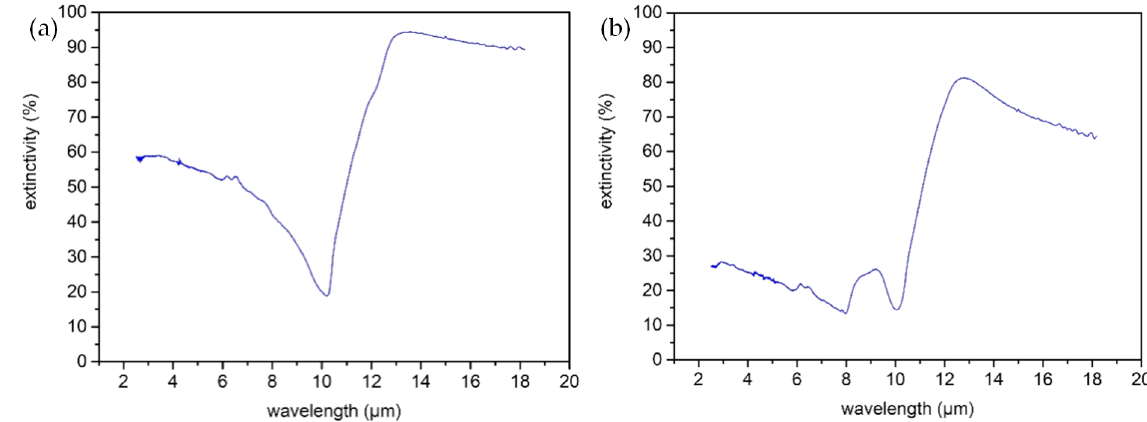
Figure 13. FTIR curves of SiC particle samples: ( a ) sample #1; ( b ) sample #2.